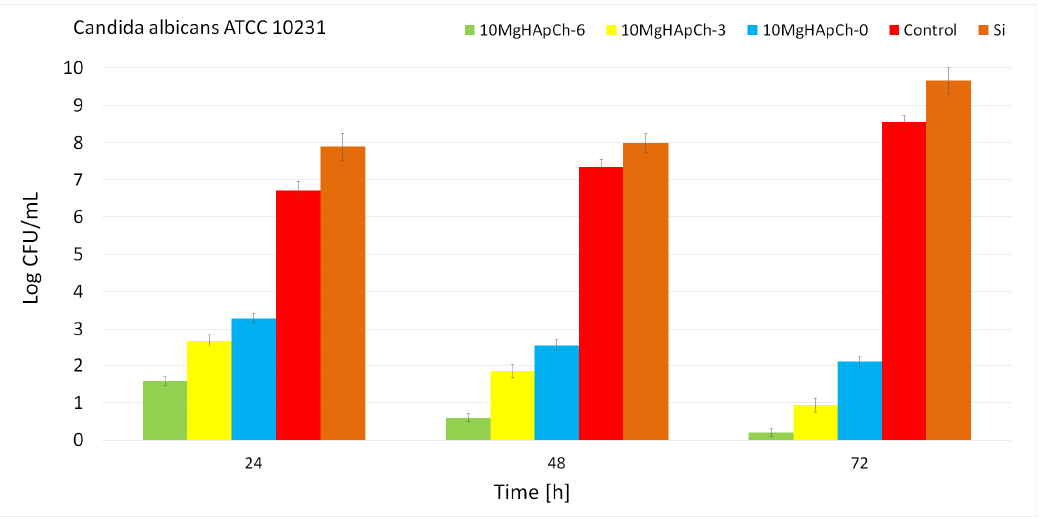
Figure 17. The graphical representation of the antimicrobial activity of Si discs, 10 MgHApCh-0, 10 MgHApCh-3, and 10 MgHApCh-6 composite layers against C. albicans (ATCC ® 10231) fungal cells after 24, 48, and 72 h of